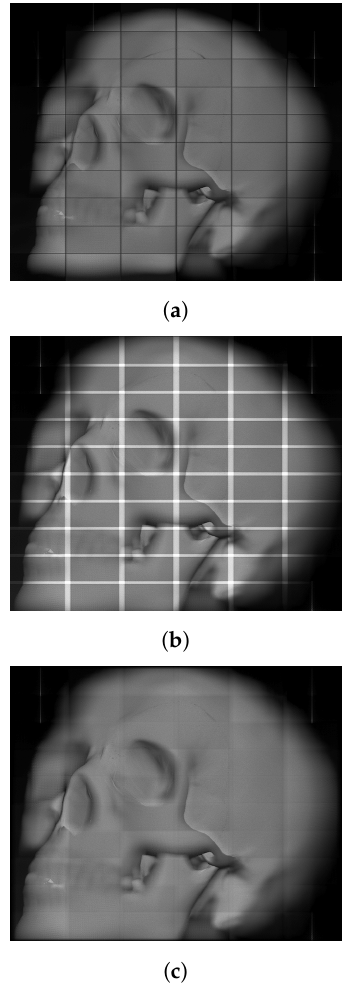
Figure 7. Reconstructed images from 3D skull holograms. ( a ) Normal output without overlapping; ( b ) 10%, 10% overlapping without filter; ( c ) 10%, 10% overlapping with